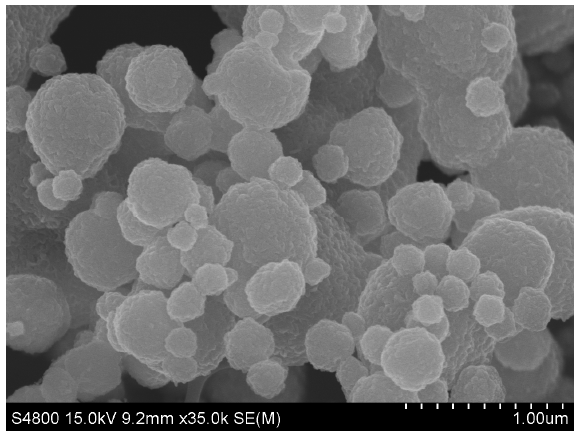
Figure 5. SEM image of NiO microspheres prepared by burning out the carbon aerogel in